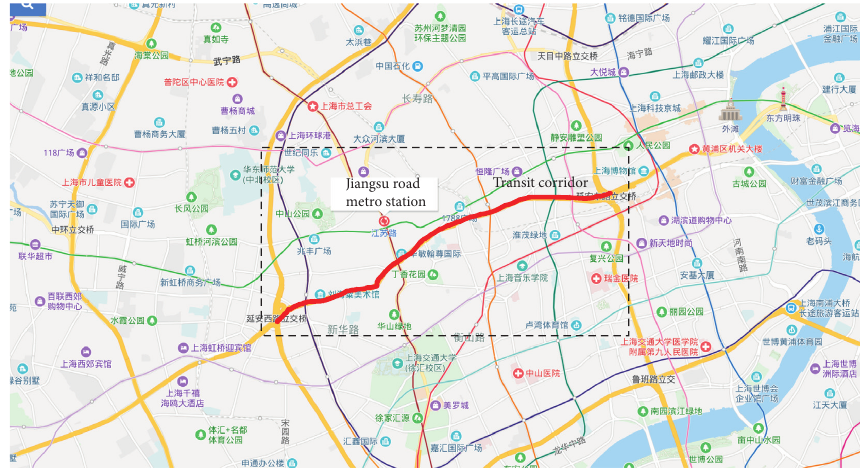
Figure 1: Layout of the transit corridor in Shanghai.